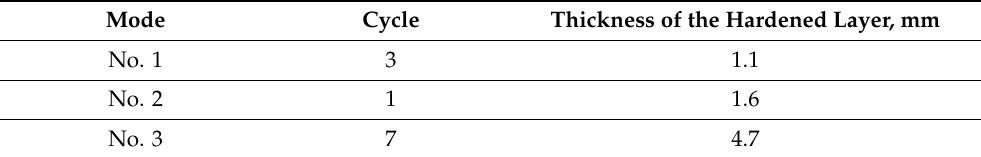
Table 2. The influence of EPTCH modes on the formation of the thickness of the hardened layer. Mode Cycle Thickness of the Hardened Layer, mm